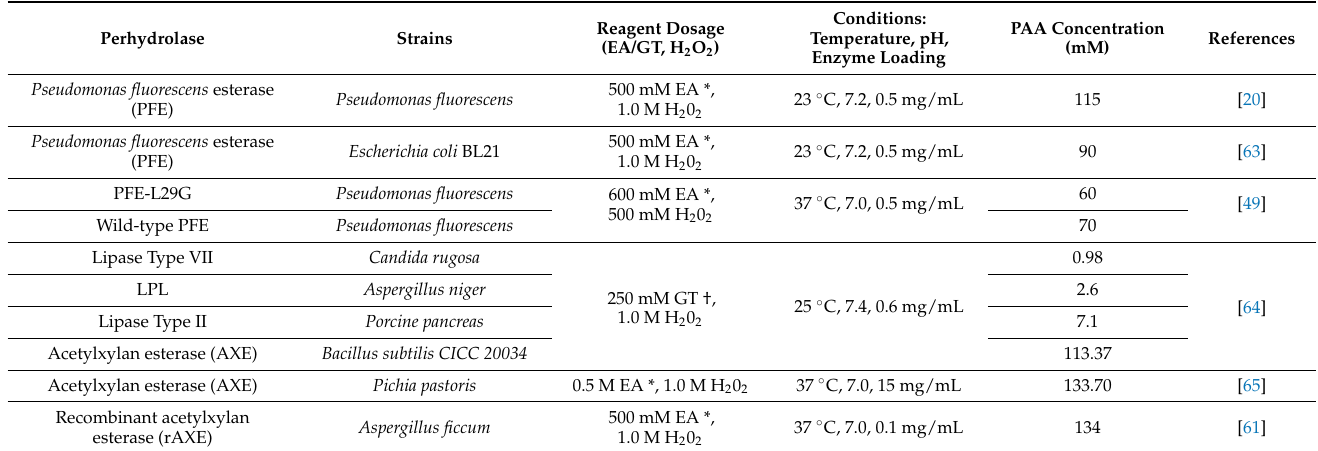
Table 3. Perhydrolases producing strains and enzyme-generated